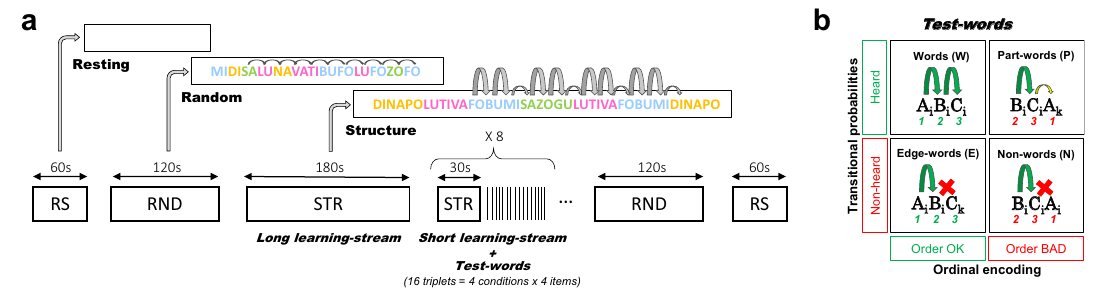
Figure 1. Experimental protocol. ( a ), The experiment started with a resting state period (1 mn), followed by a random stream (2 mn) then the learning stream was presented (3 mn). This long Structured stream was followed by a test phase including 8 blocks of 16 triplets presented in isolation with a jittered ISI (2–2.5 s). Each block was separated from the next by short Structured streams (30 s) to maintain learning. A Random stream and a Resting state period were again recorded at the end of the experiment to control for the effect of time, and notably infant vigilance, on EEG recordings. ( b ), Possible types of test words. Test words could have violations in the TPs between the second and third syllables, in the ordinal position of the syllables (1 2 3 vs. 2 3 1), or